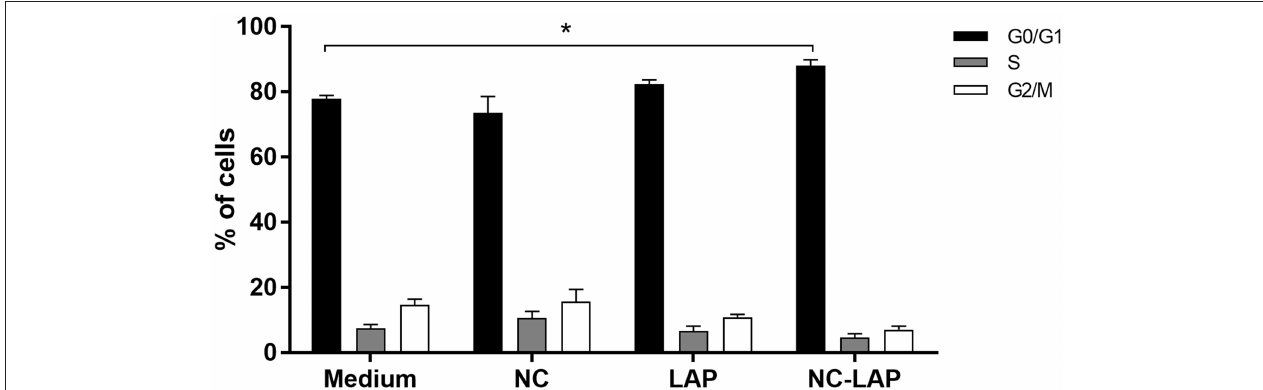
FIGURE 4 | NC-LAP treatment induces cell cycle arrest in T24 cells. T24 cells were treated with LAP or NC-LAP at 5 µ M, as well as the relative amount of NC for 48h. Cell cycle arrest analysis was assessed with propidium iodide staining and flow cytometry. Data are represented by the mean ± SEM with data from three independent experiments. Two-way ANOVA with Tukey post-hoc was used to analyze statistical significance. (*) represents significant difference (for each phase) between the different treatment in relation to the control group. Significance was considered at P < 0.05.